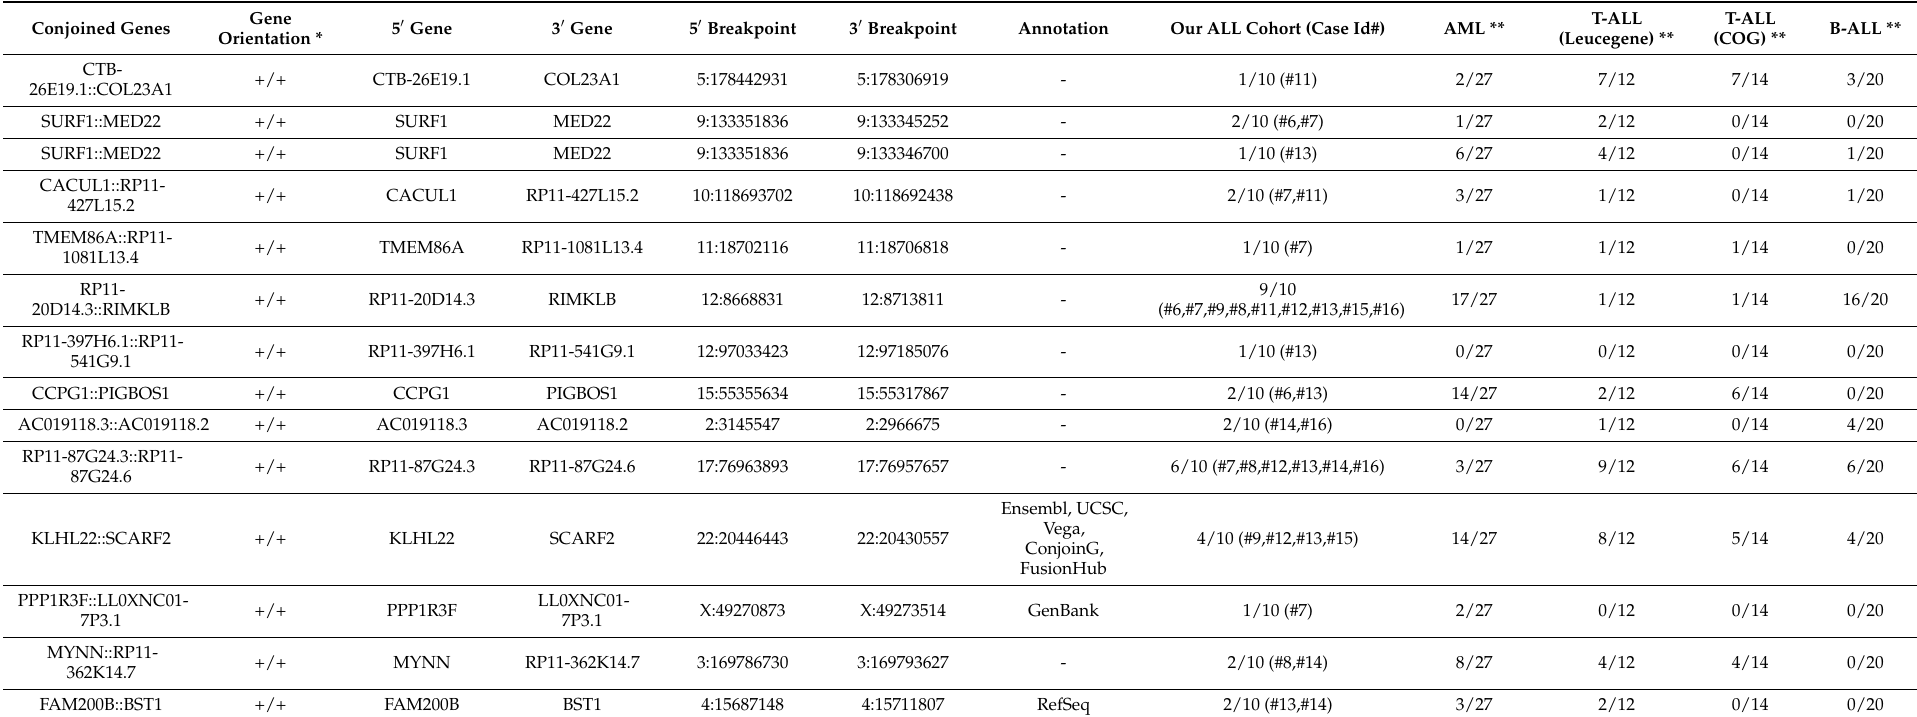
Table 3. Leukemia-specific conjoined